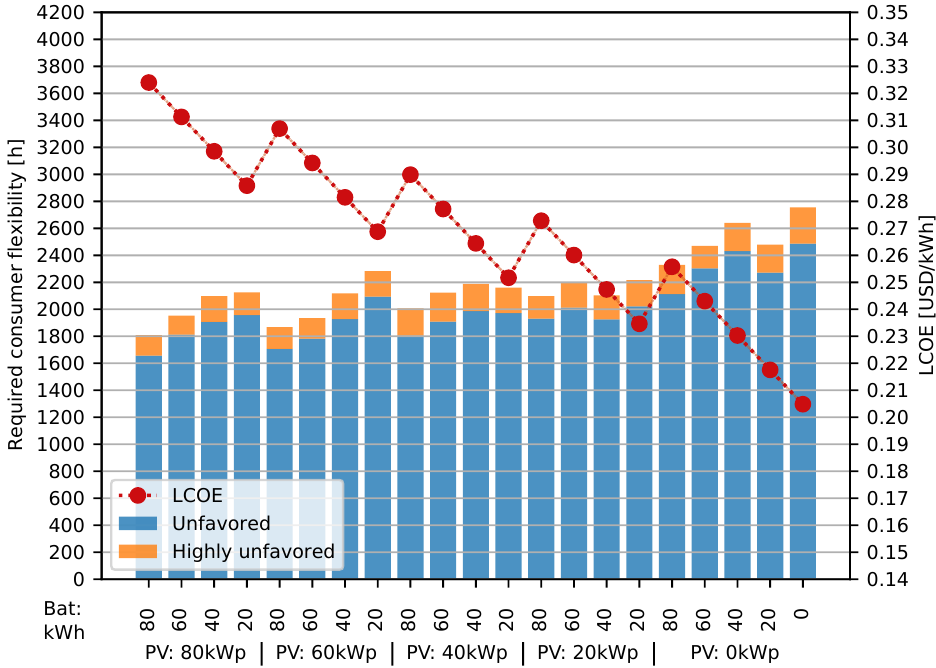
Figure 13. LCOE and required consumer flexibility over decreasing system component dimensioning for the 75L/s